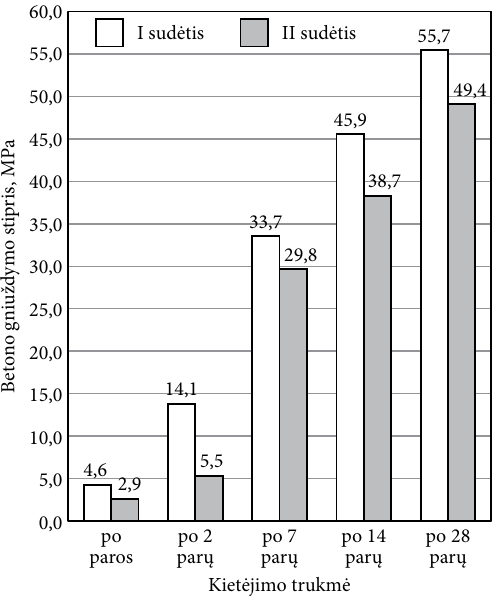
Fig. 8. Testing data of concrete mechanical